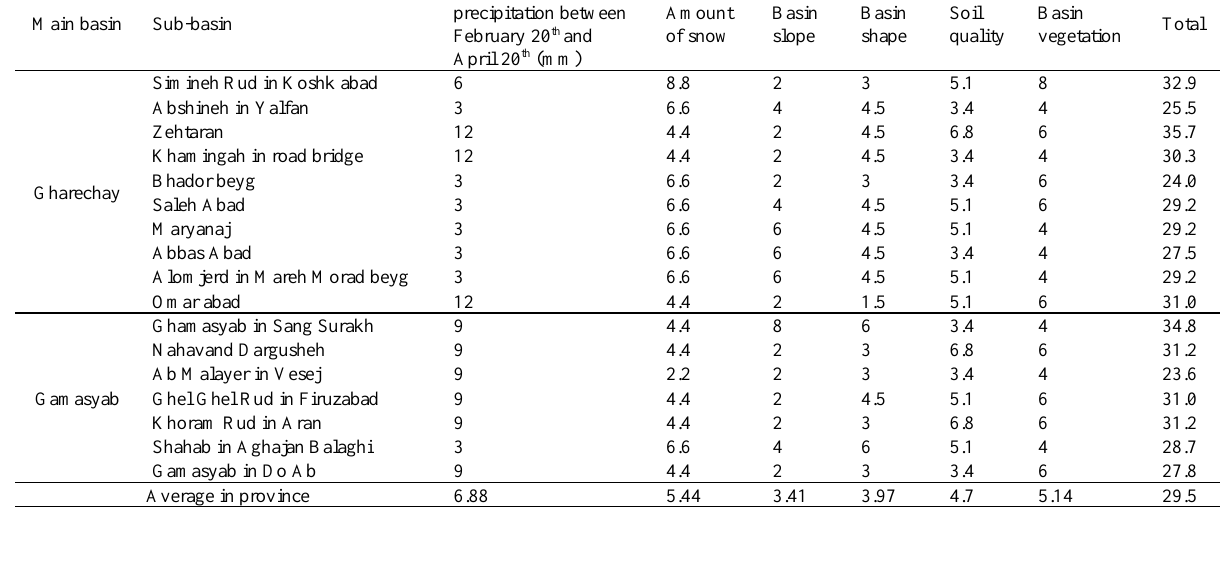
Maximum 24- hour precipitation between February 20 th and April 20 th (mm)